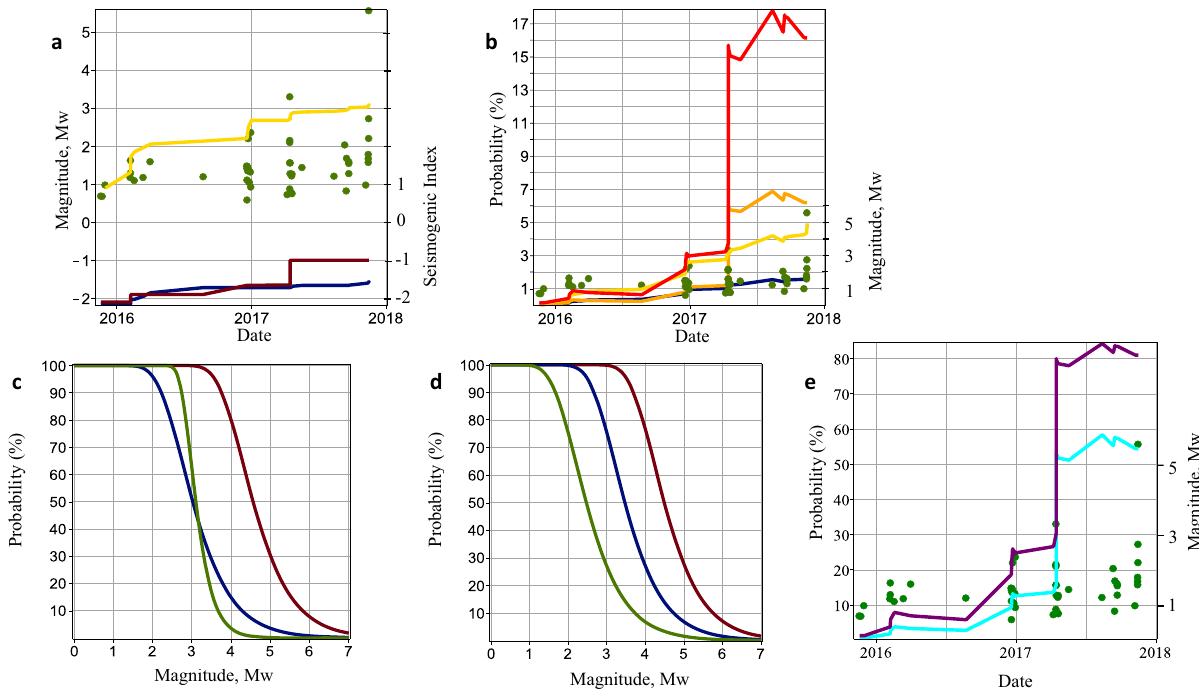
Fig. 3 Magnitudes and M max worst-case exceedance probabilities of induced earthquakes at Pohang. a , b , e Mw ≥ 0.9 earthquakes (green points). a Expected 24 M max (yellow line; see ‘ Methods ’ section), sup Σ ð t Þ assuming independent injection phases (dark-red line) and assuming the total stimulation period is a single continuous injection (dark-blue line). b Probabilities of a Mw5.5 earthquake computed from Eq. (1) with b = 0.65 (red and yellow lines) and b = 0.73 (orange and dark-blue lines) using both sup Σ ð t Þ estimates in a , respectively. c , d Probabilities of given magnitudes. c A Pohang-like situation: Δ V ≈ 5850 m 3 , b = 0.65, Σ = − 1 (red line) and Σ = − 2 (blue line); and a Basel-like situation: Δ V ≈ 11,570 m 3 , b = 1.44, Σ = 0.25 (green line). d Probabilities f f due to the termination of fl uid injection based on magnitude thresholds: The Pohang-like situation in c (dark-red line), Mw3.3 (dark-blue line), and Mw2.3 (green line). e Probabilities of a stimulation-zone size event: the same as the red line in b , but for Mw4.0 (purple line) and Mw4.5 (cyan